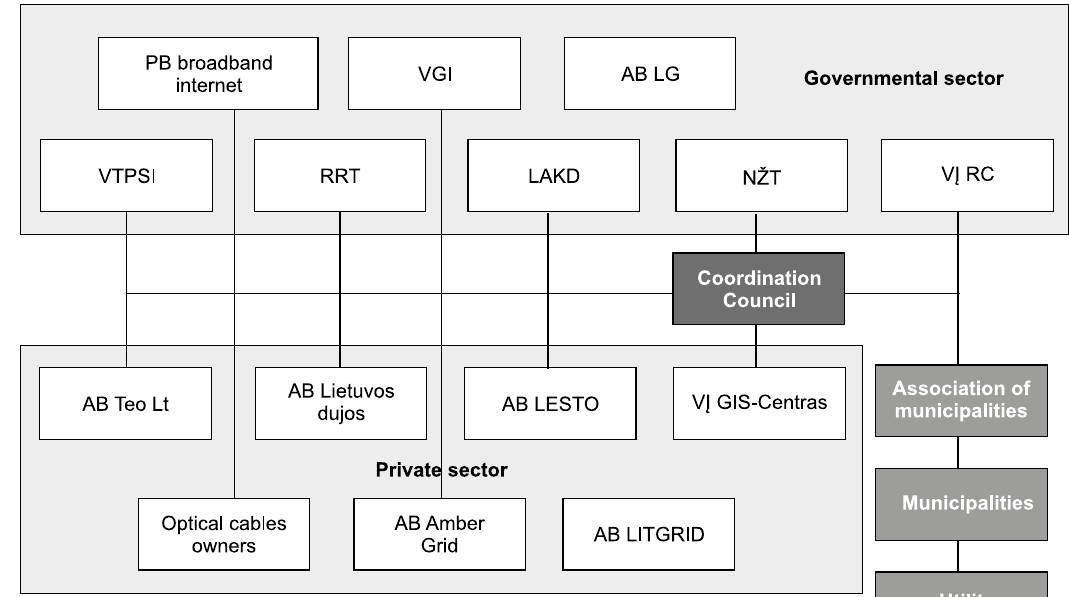
Fig. 1. TIIS cooperation and financing